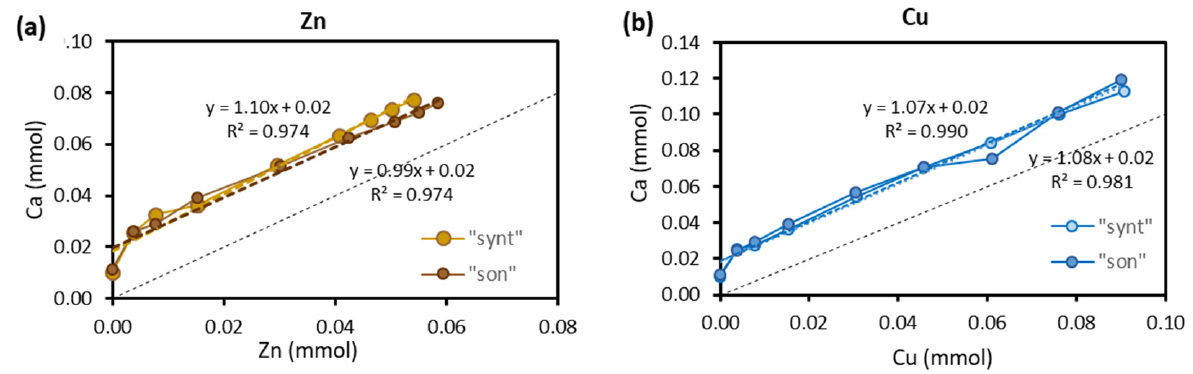
Figure 8. Relationship between the number of moles of released Ca 2+ vs the number of moles of adsorbed Zn ( a ) and Cu ( b ).